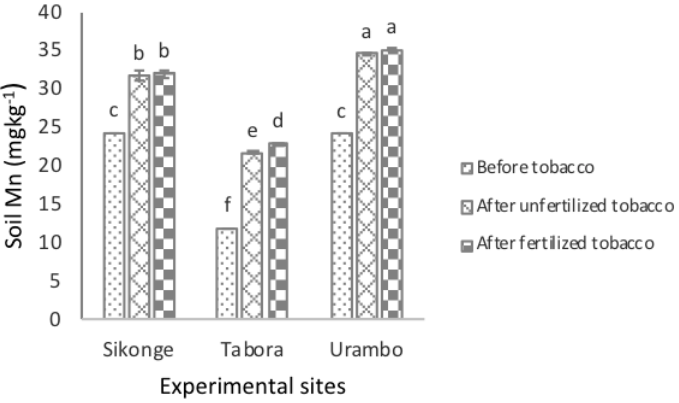
Figure 4. The effect of tobacco and NPK + CAN fertilization on the extractable Mn in soils. The solubility of the extractable Zn in soils for the Urambo and Tabora sites was significantly ( p < 0.001) lower than in the Sikonge site. The Zinc levels in soils increased significantly from 0.32 to 0.40 mg kg − 1 in unfertilized tobacco-cultivated soils, which is